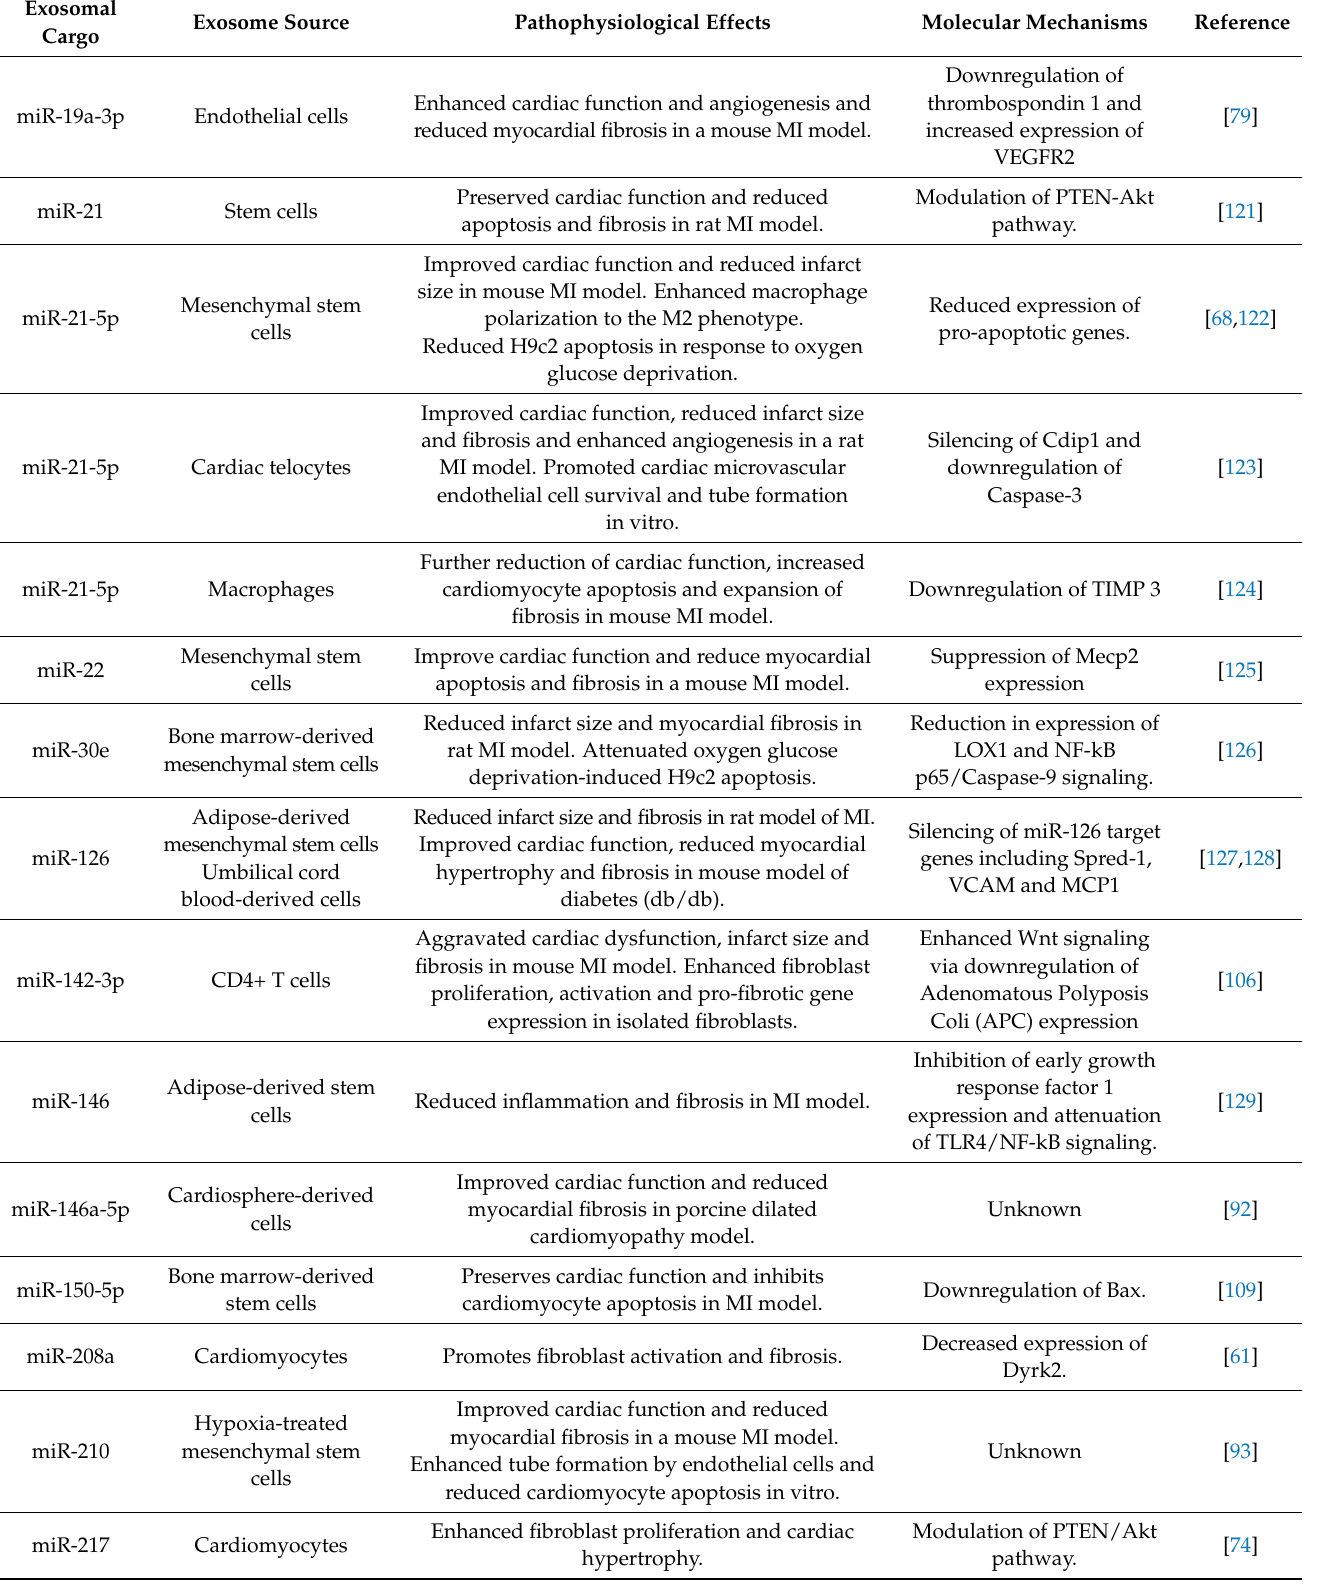
Table 1. Exosomal cargo that modulate cardiac fibrosis. Cargo that has been identified to modulate cardiac fibrosis or activation of cardiac fibroblasts is presented along with its cell(s) of origin, pathophysiological effects, and molecular mechanisms (if known). Only cargo whose functions have been experimentally verified are